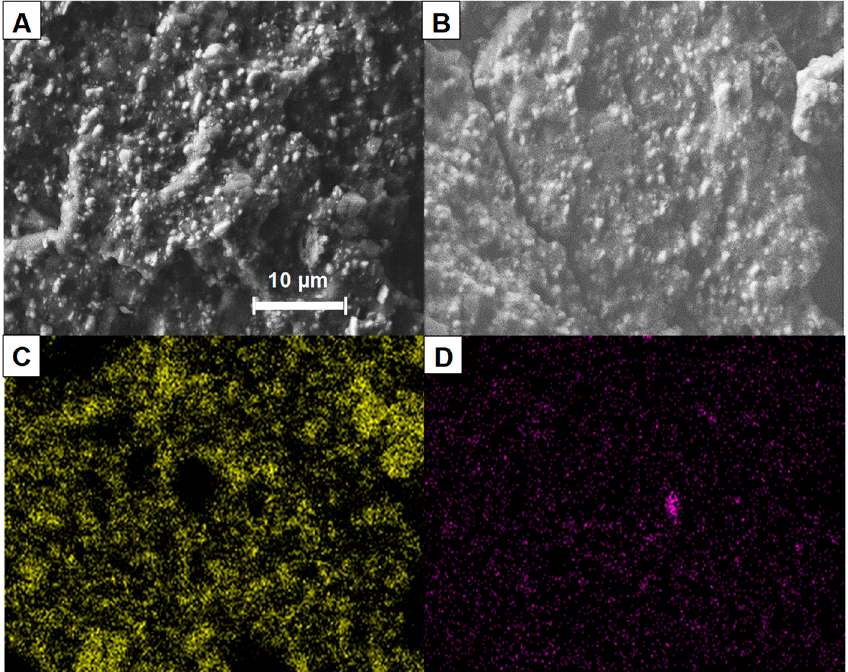
Figure3. ( A )SEMmicrographoffracturedsurfaceofE-PE / 120ATH / 10TRZ / 5claycomposite, ( B ) scanned Figure 3. (A ) SEM micrograph of fractured surface of E-PE/120ATH/10TRZ/5clay composite, ( B ) area of E-PE / 120ATH / 10TRZ / 5clay composite for elemental analysis, ( C ) aluminum and ( D ) Si scanned area of E-PE/120ATH/10TRZ/5clay composite for elemental analysis, ( C ) aluminum and ( D ) Si mapping.